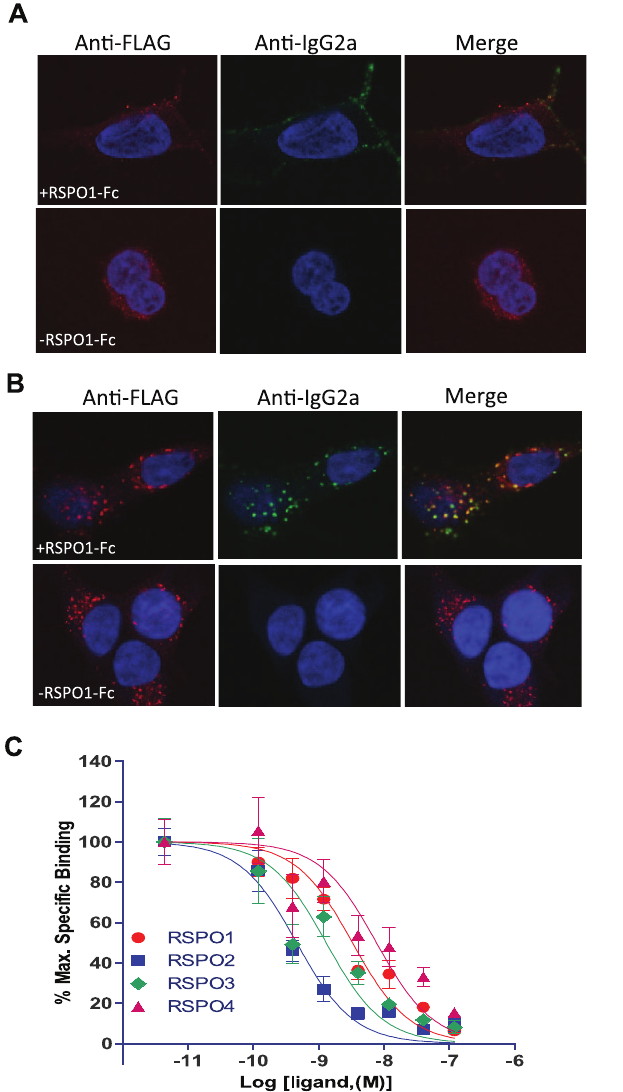
Figure 1. Binding of R-spondins to LGR6 by confocal immuno- fluorescence analysis and competition binding assay. A&B, HEK293 cells stably expressing Flag-LGR6 were incubated with mRSPO1-Fc or control conditioned media (CM) at 4 u C (A), or at 37 u C (B). Flag-LGR6 was detected with a Cy3-labeled anti-Flag antibody (red) and mRSPO1-Fc was detected using Alexa488-labeled anti-IgG2a antibody (green). Nuclei were counterstained with To-Pro-3 (blue). The data shown are from one of three independent experiments with similar results. C, Quantitative binding analysis using a whole-cell-based assay. HEK293 cells stably expressing Flag-LGR6 were incubated with mRSPO1-Fc plus serial dilutions of purified recombinant RSPO1–4. Maximum specific binding is defined by the difference between the data with and without mRSPO1-Fc, which is , 50% of total binding in general. All error bars are SEM (n=3).